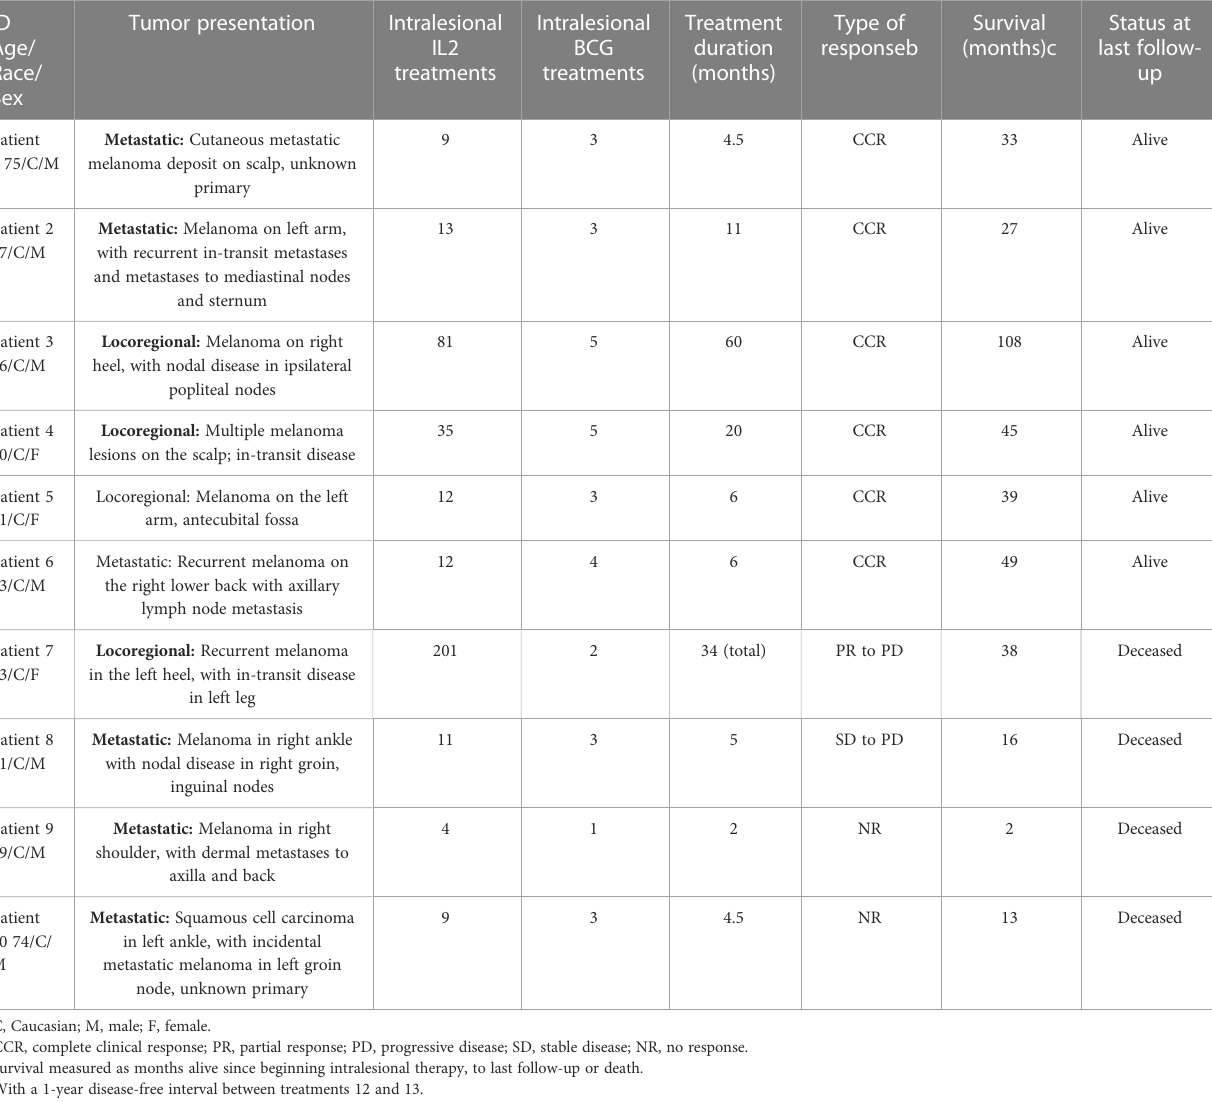
TABLE 1 Patient characteristics, treatment characteristics and outcomes following the intralesional IL2 and BCG treatment for metastatic or locoregional melanoma.